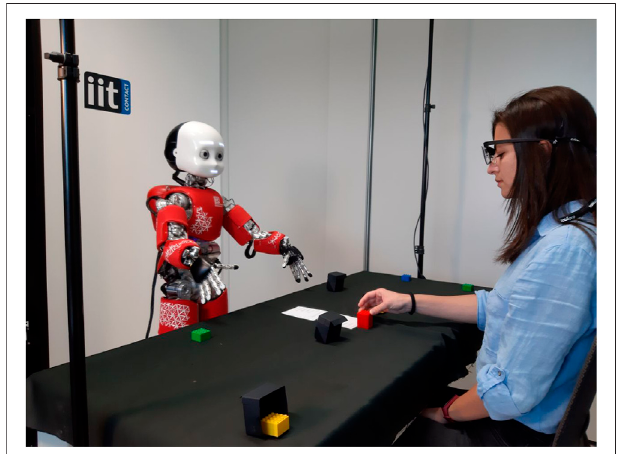
FIGURE 1 | A participant and the robot iCub performing the